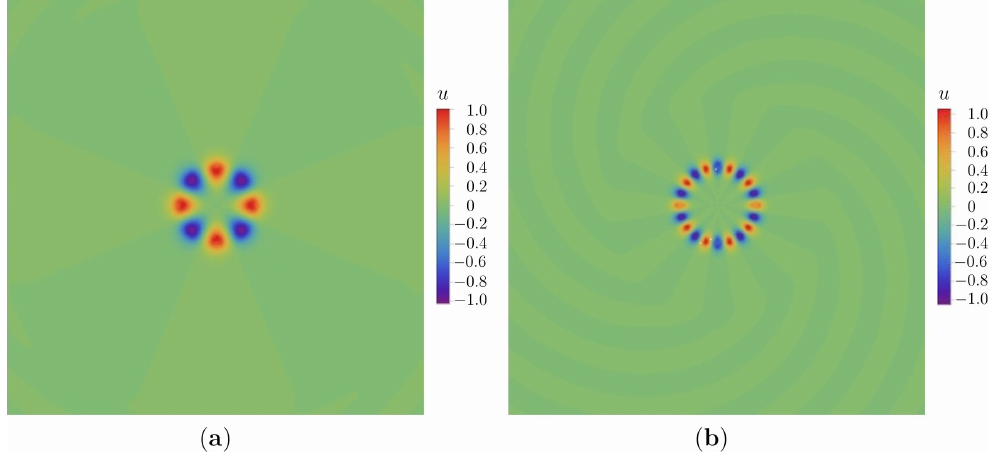
Figure 1. Localised modes in an elastic plate, containing two concentric rings of spring-mass resonators, obtained for ω = 10 rad/s and for ( a ) q = 4 and ( b ) q = 10. In the calculations, the plate is assumed to be made of aluminium (Young’s modulus E = 70 GPa, Poisson’s coefficient ν = 0.33 and mass density ρ = 2700 kg/m 3 ) and